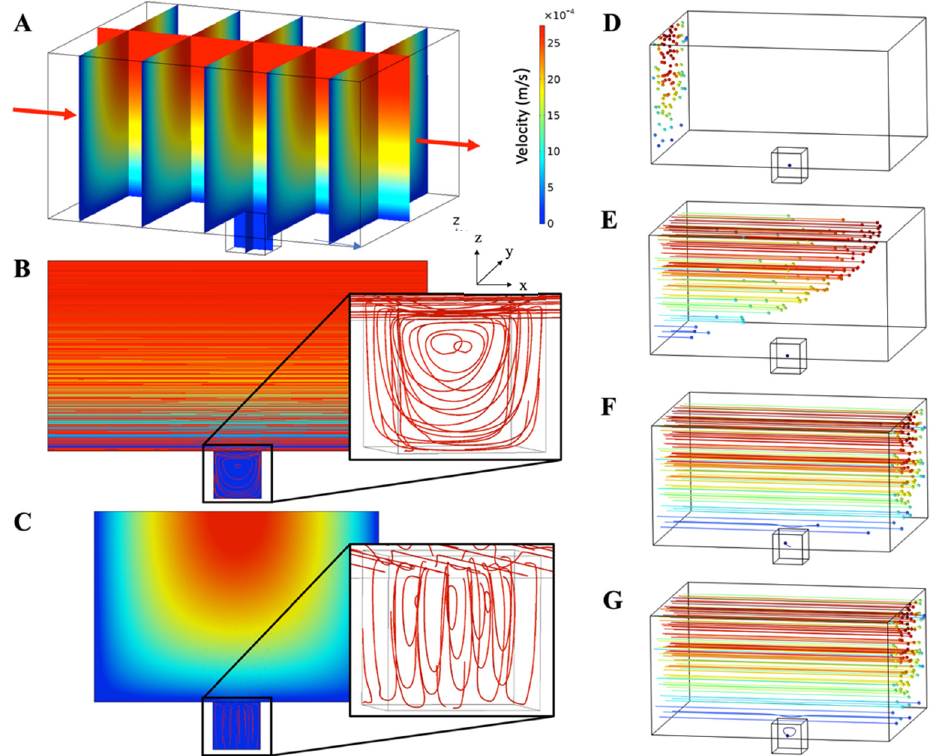
Figure 4. ( A ) Simulation of the velocity field in the channel and the microwell for an inlet flow velocity of 1.32 10 − 3 m/s. The top surface is the symmetry plane of the channel (middle plane of the channel at 200 µ m). ( B ) Zx cross-section showing the velocity field and the streamlines (red colour). The insert shows a zoom of the microwell in 3D with the streamlines represented as tubes. ( C ) Zy cross-section showing the velocity field and the streamlines (red colour). The insert shows a zoom of the microwell in 3D with the streamlines represented as tubes. ( D – G ) Simulation of the flow of yeast cells with a flowing medium in the channel and the circular movement of a yeast cell in the microwell at ( D ) 0.00 s, ( E ) 0.13 s, ( F ) 0.8 s, and ( G ) 3.7 s (the colours of the streamlines correspond to